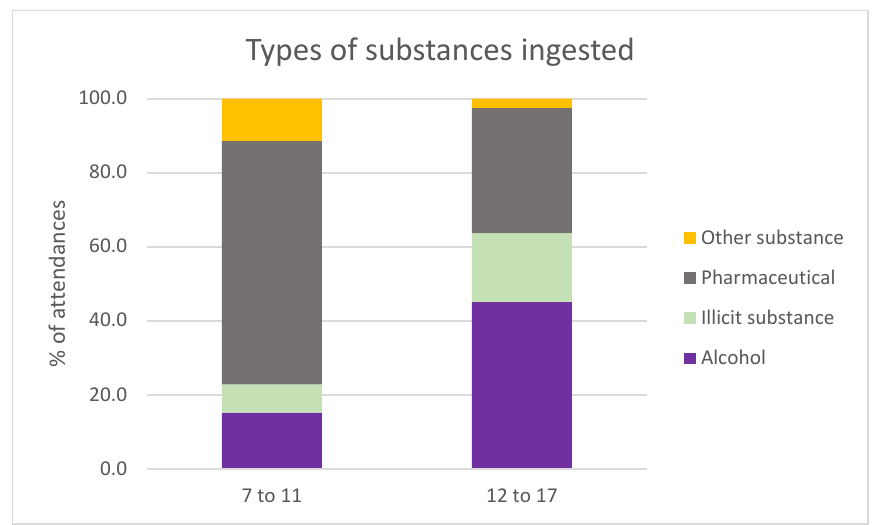
Figure 5. Ambulance attendances as a function of substances ingested. These aged 7 to 11 are more